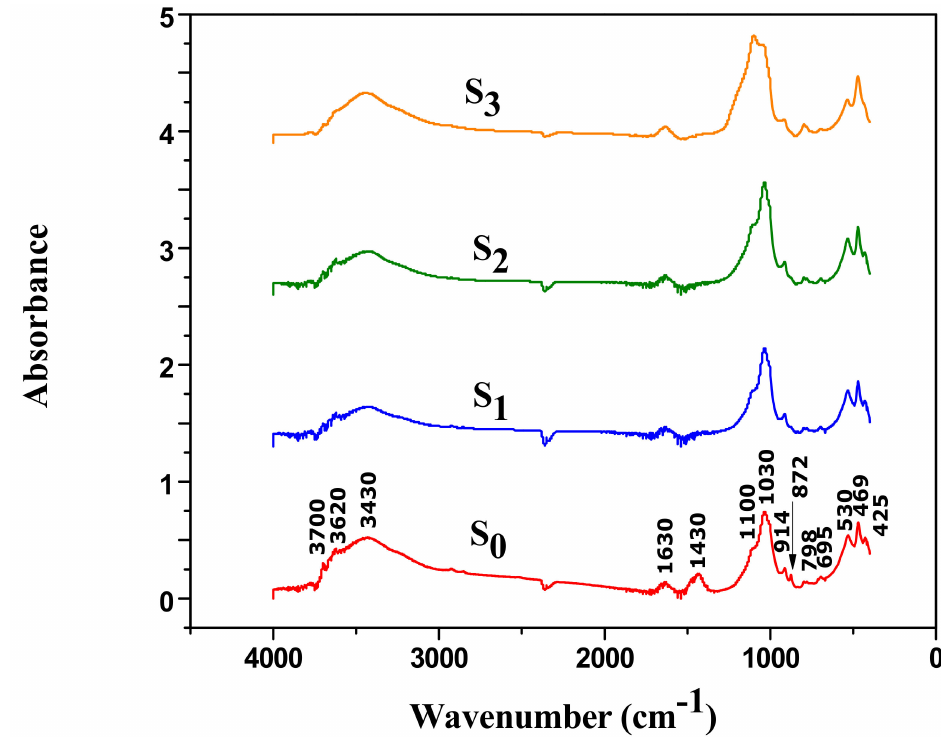
Figure 8. Infra-red spectra of raw material ( S 0 ) and acid-activated clays ( S 1 , S 2 , S 3 ).